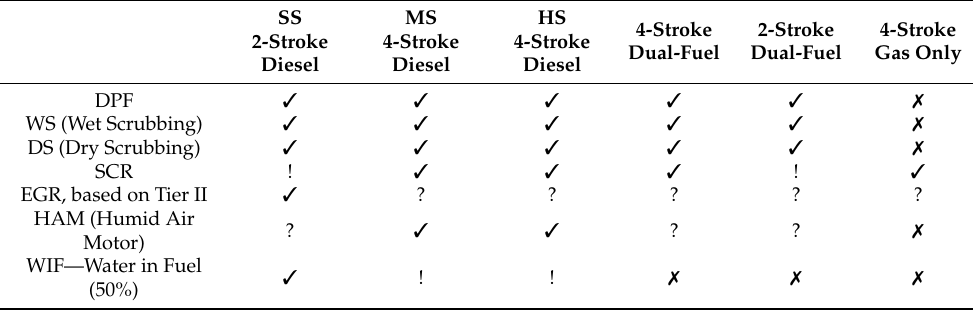
Table 3. Emissions abatement technologies integration with different engine types.